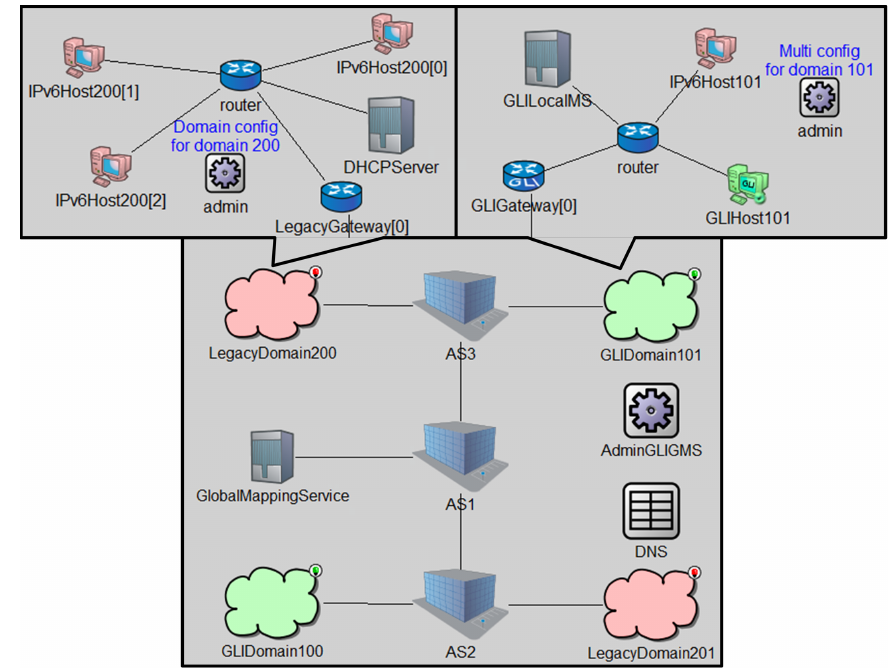
Figure 10. GLI-Split architecture in the INET Framework for OMNeT++ with GLI-domains and classic IPv6